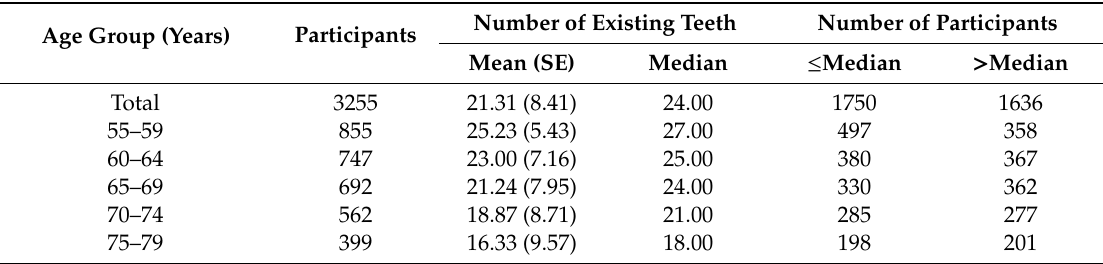
Table 2. The number of existing teeth and binary status based on the median number of existing teeth by age